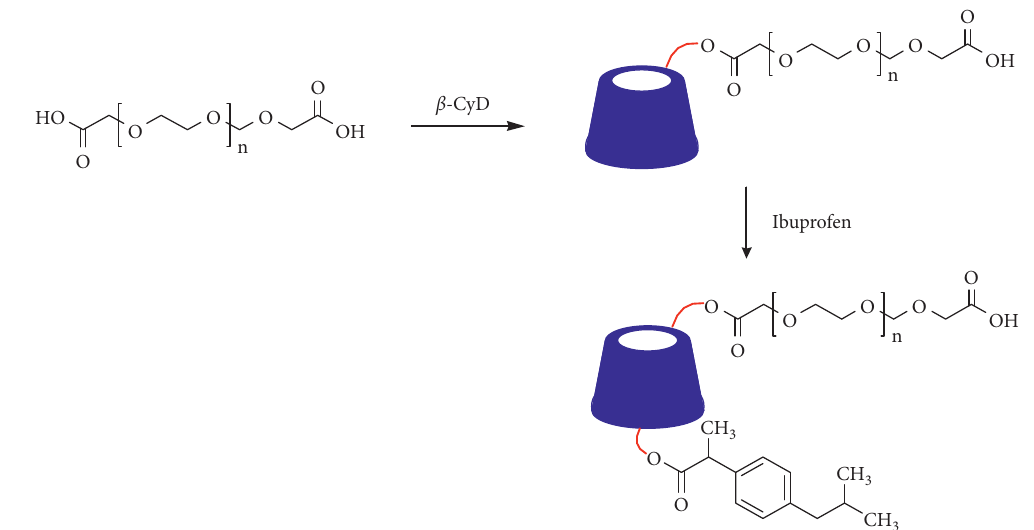
Scheme 2: Synthesis routes of the ibuprofen- β -CyD-PEG